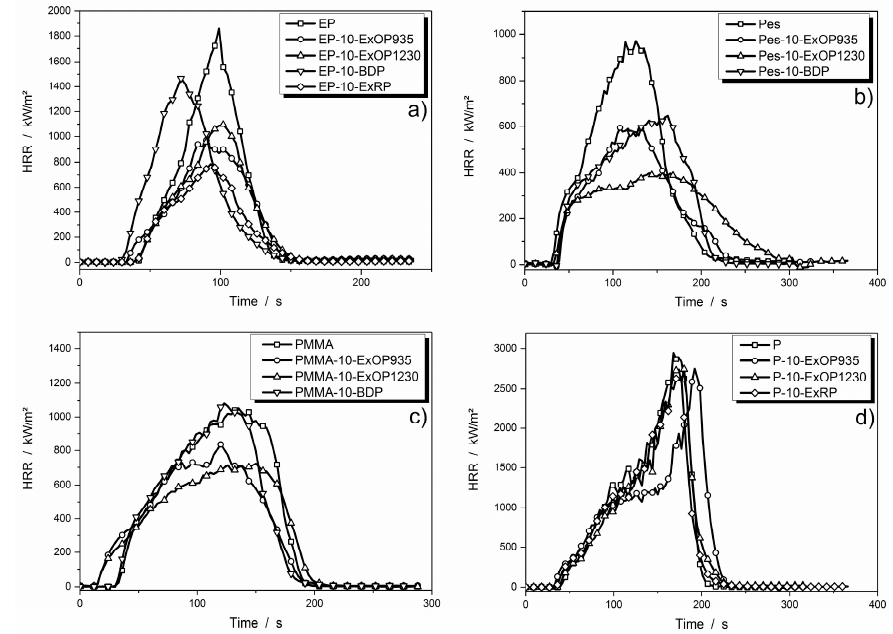
Figure 3. Cone calorimeter heat release rate (HRR) curves of flame retardants in: DGEBA/IPDA ( a ); Pes-resin ( b ); PMMA resin ( c ); and paraffin ( d ) with a concentration of 10 wt %.